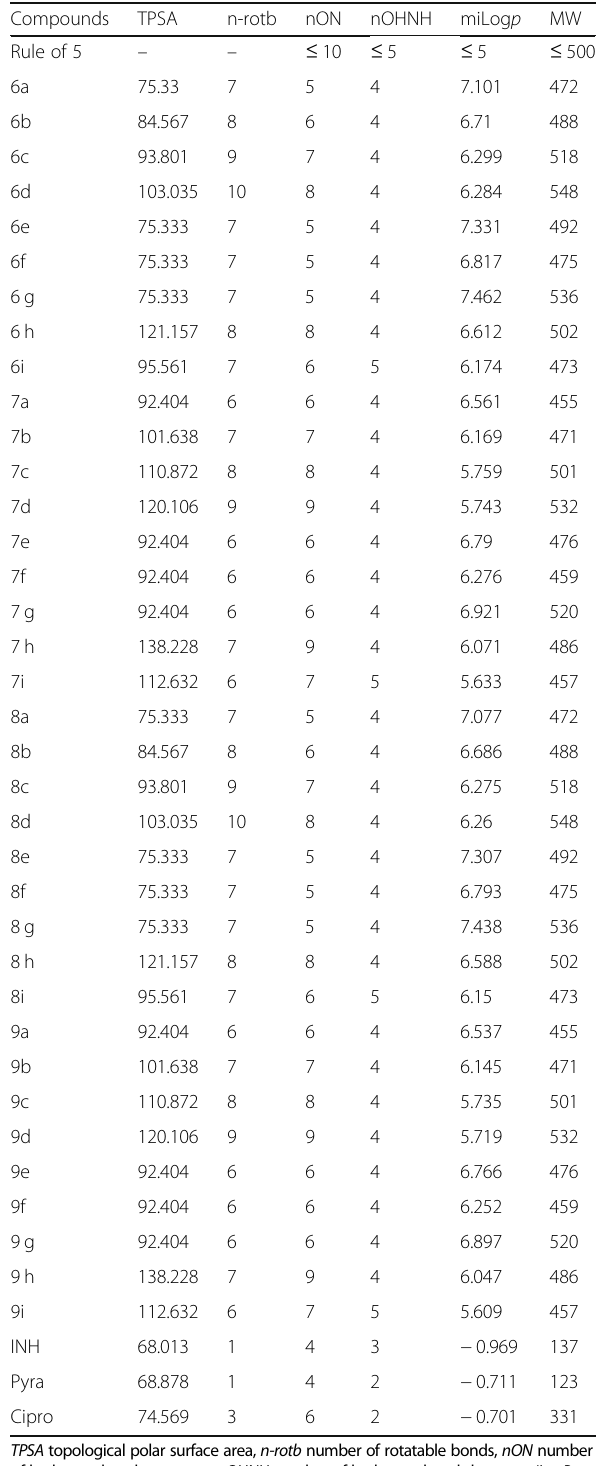
Table 2 Molecular parameters of 7-chloro-4-aminoquinoline based semicarbazones and thiosemicarbazones ( 6a-i ), ( 7a-i ), ( 8a-i ), and ( 9a-i ) Compounds Rule of 5